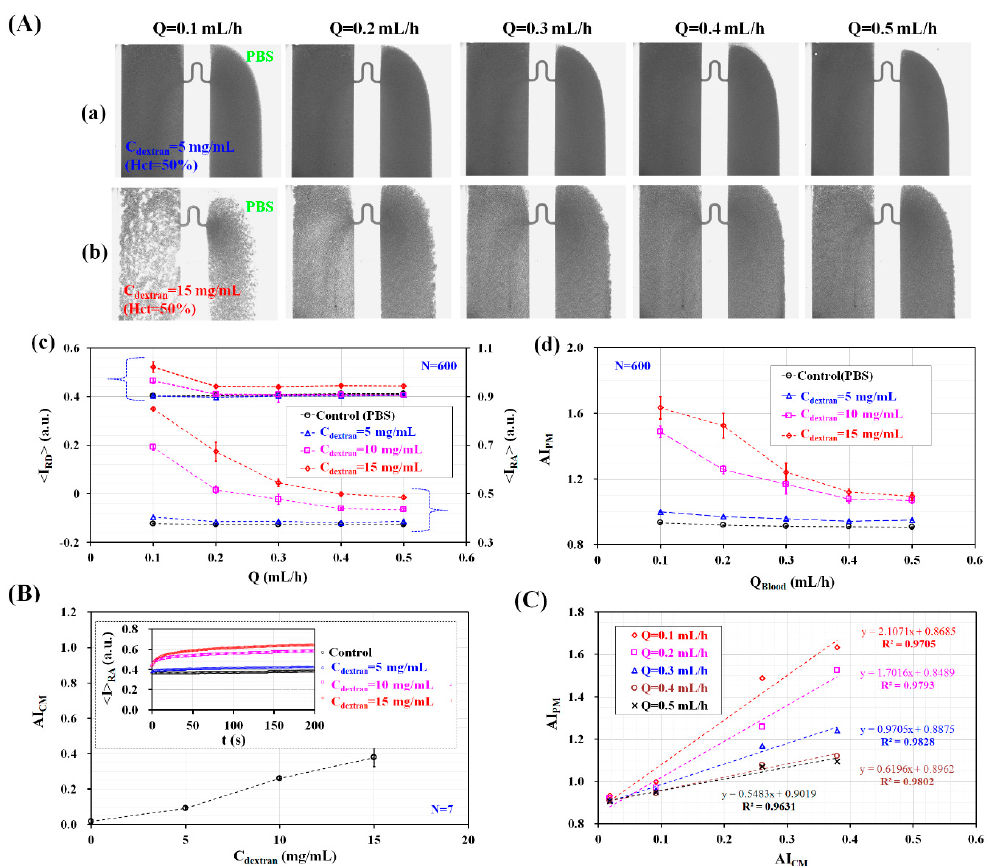
Figure 3. Quantitative evaluations of RBC aggregation index (AI PM ) under constant blood flow. Blood (Hct = 50%) was prepared by adding normal RBCs into various concentrations of dextran solution (C dextran ) (C dextran = 0 mg/mL, 5 mg/mL, 10 mg/mL, and 15 mg/mL). Blood and PBS solution were delivered into the microfluidic device at the same flow rate (Q PBS = Q Blood = Q) (Q = 0.1 mL/h, 0.2 mL/h, 0.3 mL/h, 0.4 mL/h, and 0.5 mL/h). ( A ) Variations of RBC aggregation with respect to C dextran and Q. (a) Microscopic images for representing RBC aggregation of blood (RBCs suspended in dextran solution of C dextran = 5 mg/mL) with respect to Q. (b) Microscopic images for representing RBC aggregation of blood (RBCs suspended in dextran solution (C dextran = 15 mg/mL)) with respect to Q. (c) Variations of <I RA > and <I RD > with respect to C dextran and Q. (d) Variations of AI PM with respect to C dextran and Q. ( B ) Variations of conventional RBC aggregation index (AI CM ) with respect to C dextran . Inset shows temporal variations of image intensity of RBCs with respect to C dextran , especially at stasis. ( C ) Quantitative comparison between AI PM and AI CM . Regression coefficient of linear regression yielded higher value of R 2 > 0.96 with respect to Q.